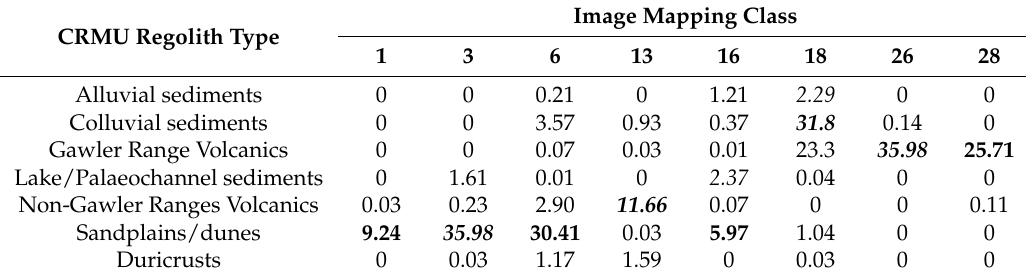
Table 4. Mean GOF (%) from Mapcurves analysis: bold values are the highest GOF for the comparison of image mapping with the CRMU regolith type, and italicized values are the highest GOF for the comparison of CRMU regolith type with the image mapping classes. Values bold and italicized are the highest GOF for both comparison